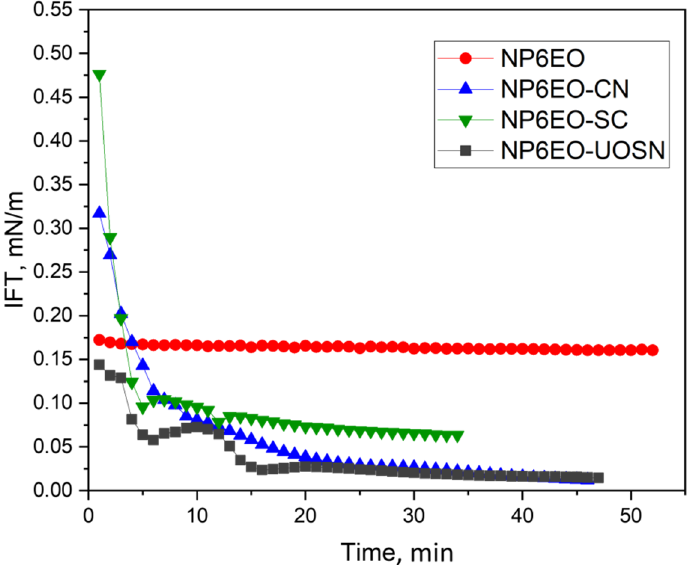
Table 2. IFT of surfactant formulations as well as the water used to prepare them.